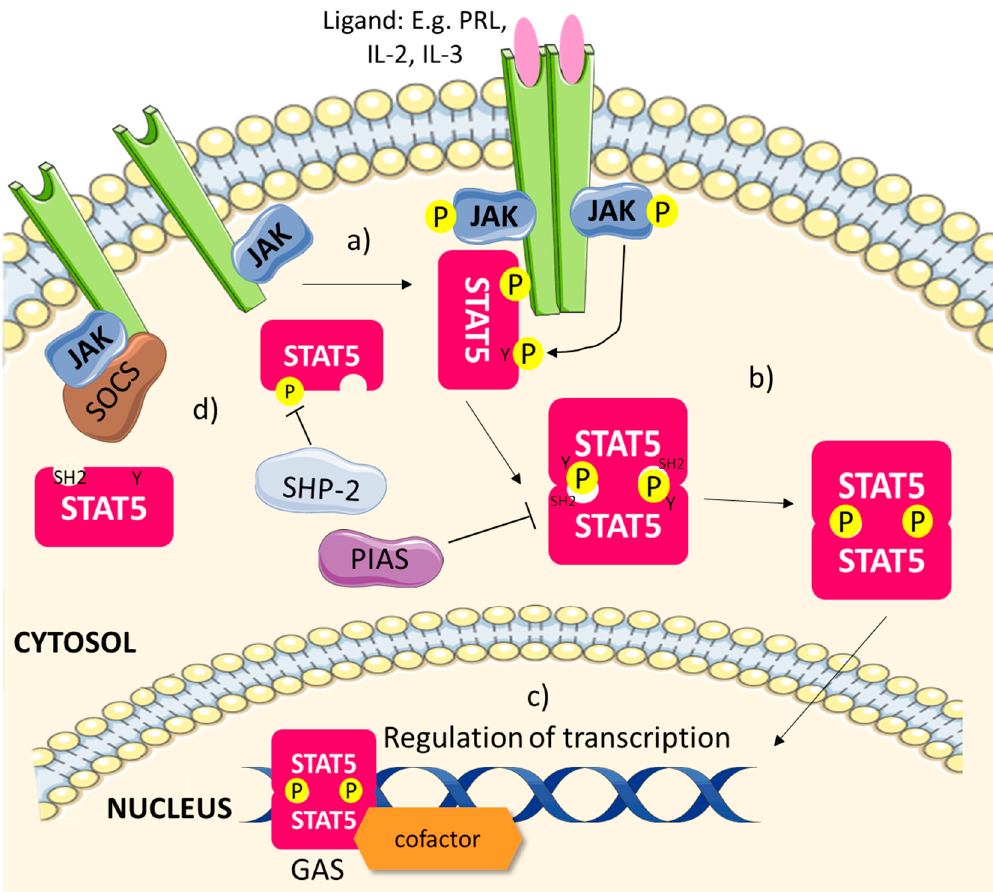
Figure 2. Activation of JAK/STAT5 signalling. ( a ) Upon the binding of ligands (e.g., cytokines) to their respective receptors, the receptors dimerise, allowing JAKs to phosphorylate each other as well as the receptor. Free STAT5 monomers in the cytosol are recruited to the receptor and are phosphorylated on their tyrosine residue by JAKs. ( b ) Phosphorylated STAT5 dimerises; the SH2 domain of one STAT5 interacts with the phospho-tyrosine (pY) region of the reciprocal STAT5. ( c ) The STAT5 dimer translocates into the nucleus and binds to interferon gamma activated sited (GAS) elements, recruiting cofactors, such as bromodomain and extra-terminal domain (BET) family proteins, to regulate the transcription of its target genes, for example cyclin D and the serine/threonine kinase Pim-1. ( d ) Negative regulators of the JAK/STAT5 pathway, tyrosine phosphatase SHP-2, suppressor of cytokine signalling (SOCS) and protein inhibitors of activated STAT (PIAS), could modulate the activation of the pathway.